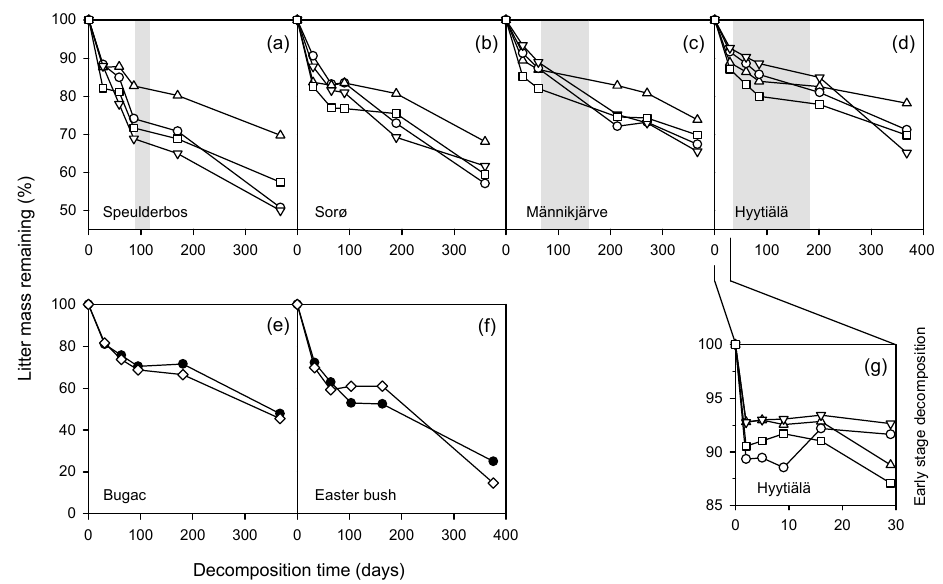
Figure 1 . Average remaining leaf litter mass during a reciprocal litter transplantation experiment of 589 four tree litter types during decomposition in four forest sites (a, b, c and d) and grass litter types during 590 decomposition in two grassland sites (e, f). Different symbols stand for different sites of litter origin 591 (and typically a different species, except the northernmost sites Hyytiälä and Männikjärve): Pinus 592 sylvestris (○) from Hyytiälä (Finland), P. sylvestris ( ▽ ) from Männikjärve (Estonia), Fagus sylvatica ( △ ) 593 from Sorø (Denmark), Pseudotsuga menziesii (□) from Speulderbos (Netherlands) (e) Festuca 594 pseudovina ( ◇ ) from Bugac (Hungary) and (f) Lolium perenne (●) from Easter Bush (UK). Data points 595 are the average of three replicate litter decomposition bags (maximum standard error between replicates 596 during the decomposition of 4.7%, not plotted). The shadowed areas correspond to the winter period 597 where the litter bags were covered by a snow layer of at least 3 cm. Panel (g) corresponds to early-stage 598 decomposition for tree litter types in Hyytiälä. Table 1 provides details of the sample sites and litter 599 characteristics. 600